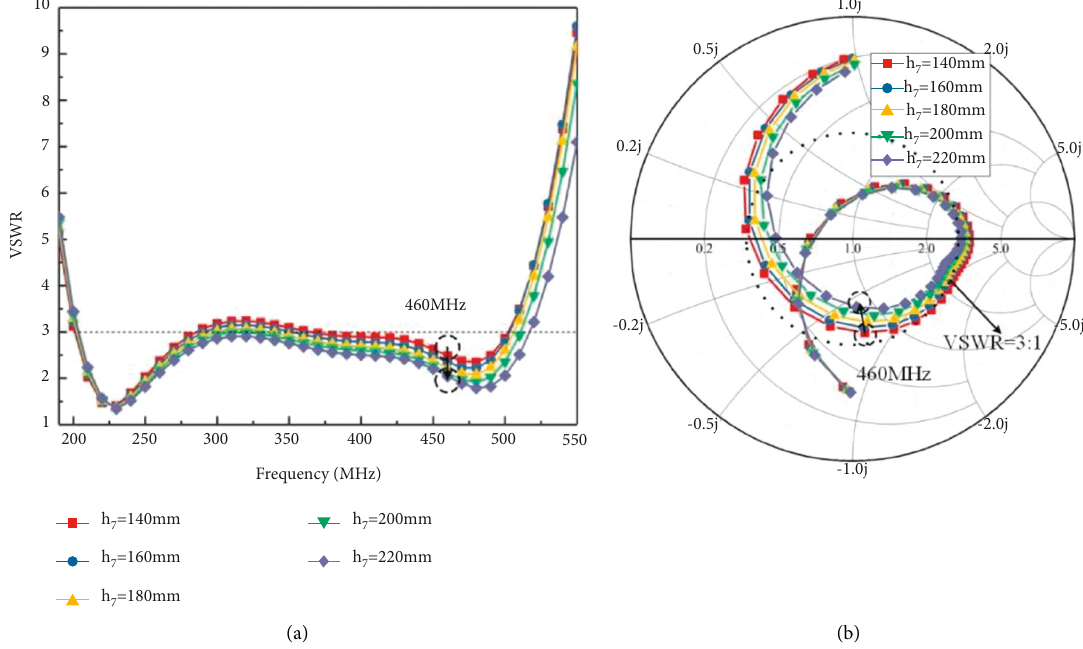
Figure 13: (a) VSWR curves and (b) Smith charts with different values of h